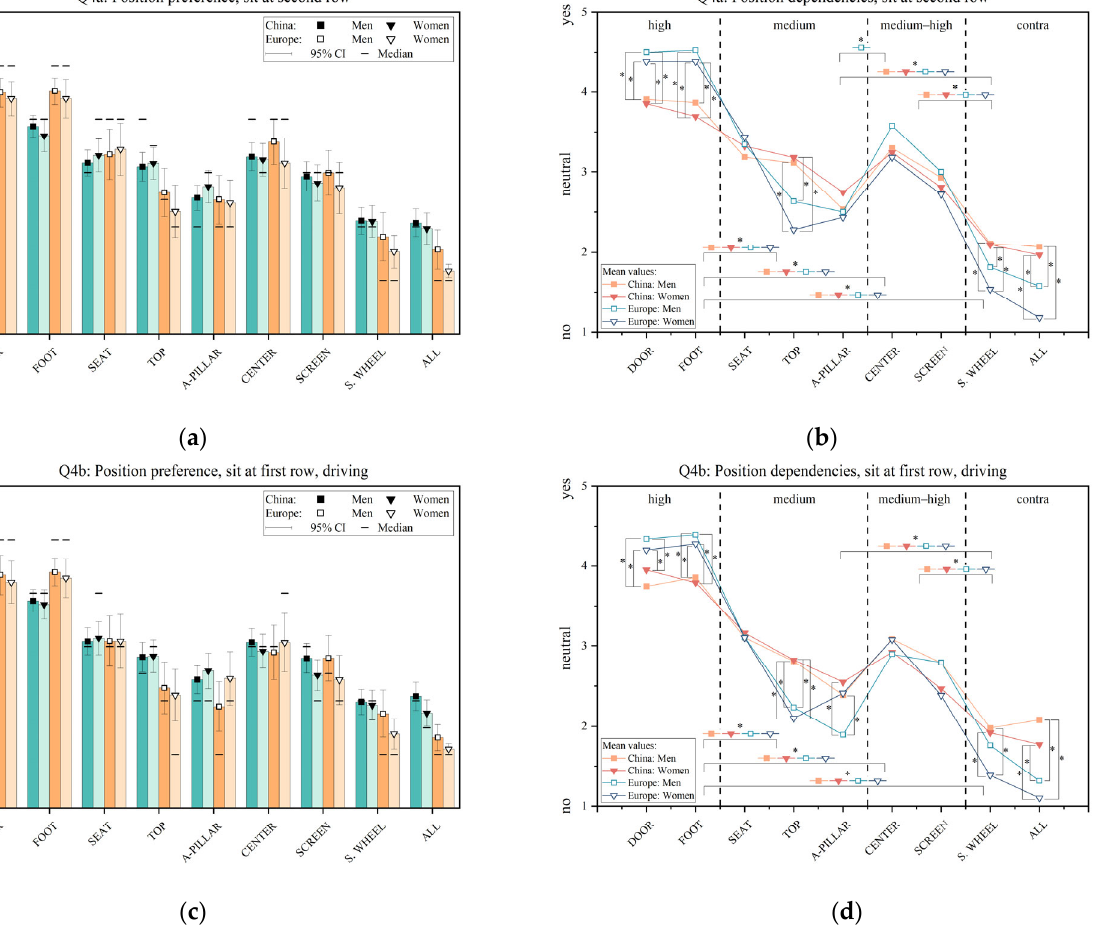
Figure 7. Light ‐ positioning rating: ( a , b ) Sit at the second row and not active driving, vehicle is driving; ( c , d ) Sit at the first row and active driving. Statistical significances p < 0.05 marked with *, separated between the Chinese and European groups and genders.